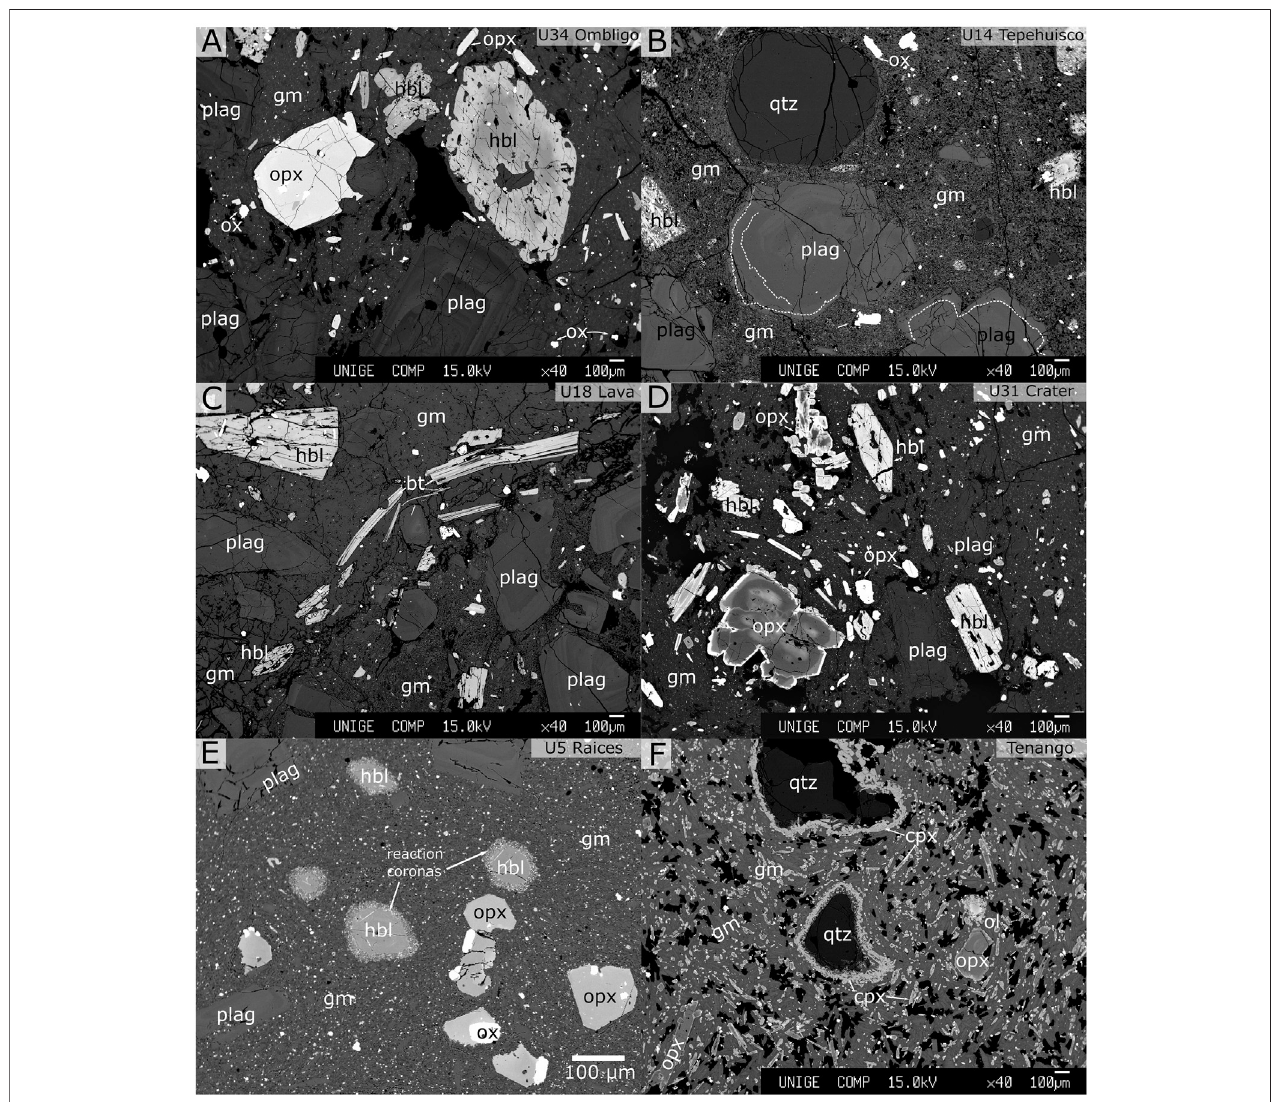
FIGURE 5 | Representative selection of petrographic features of basaltic andesite to dacitic volcanic rocks in the Nevado de Toluca area. All photomicrographs were imaged with back-scattered electrons (BSE) (A) Typical phase assemblage of zoned plagioclase (plag), zoned hornblende (hbl), orthopyroxene (opx) and Fe – Ti oxides (ox) in unit 34 (Ombligo Dome) in the central part of the crater. The groundmass (gm) is mostly composed of plag, glass and oxides. (B) Unit 14 “ Tepehuisco Dome ” containing large quartz (qtz) crystals and disequilibrium hbl. Note also the resorption and overgrowth textures of plag crystals (dashed lines). The gm is composedofplagandqtzandox. (C) Biotite(bt),hblandstronglyzonedplaginU18Lavawithgmconsistingofplag,qtzandox. (D) Stronglyzonedopxwithma fi ccores (dark)andevolvedovergrowthrimcompositions(bright)incraterunit31.Notetheeuhedralappearanceofplag,opxandhbl. (E) Reactionrimsonma fi chblandopxinU5 Raices lava. The gm is composed of plag, qtz and ox. (F) Qtz xenocrysts with reaction corona of cpx, opx and plag dominated groundmass and sparse disequilibrium olivine (ol) in Tenango lava. The gm is glassy with abundant elongated plag.